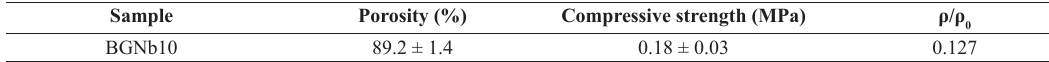
) values for BGNb10 scaffolds. 0